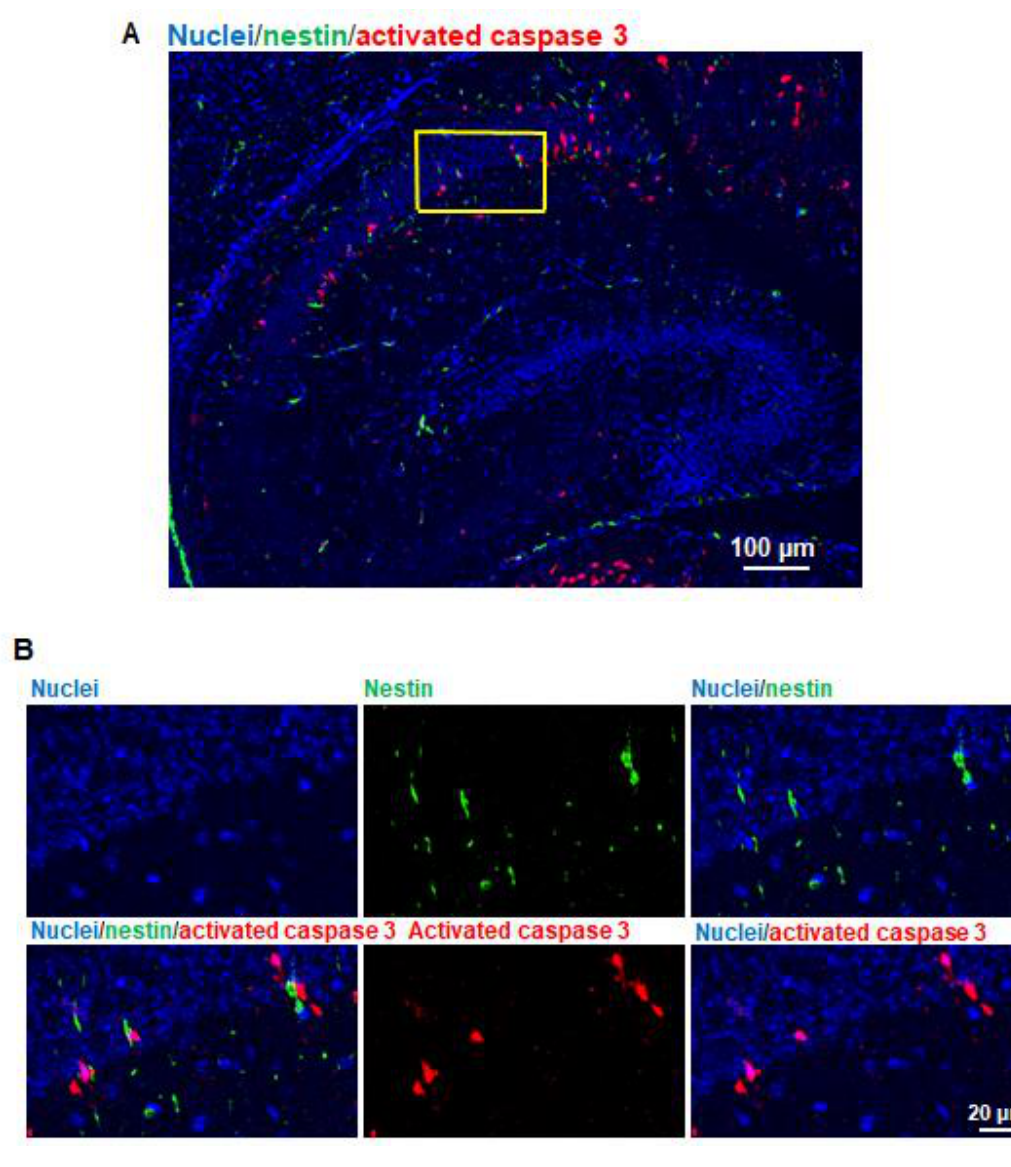
Figure 6. Propofol does not induce apoptosis in neural stem cells (NSCs) in hippocampus. ( A ) Fluorescence images of hippocampus treated with propofol. The brain sagittal sections were co-stained with activated caspase 3 and nestin (NSC marker). Cell nuclei were stained with Hoechst 33342. Blue, green, and red represent cell nuclei, nestin, and activated caspase 3 signals, respectively. Scale bar = 100 µ m; ( B ) The magnified view of the yellow-boxed region marked in Figure 6A. These images include the individual channel and overlaid images and show that activated caspase 3 and nestin signals were not co-localized in the same cells, suggesting that propofol does not induce the apoptotic NSC death. Scale bar = 20 µ